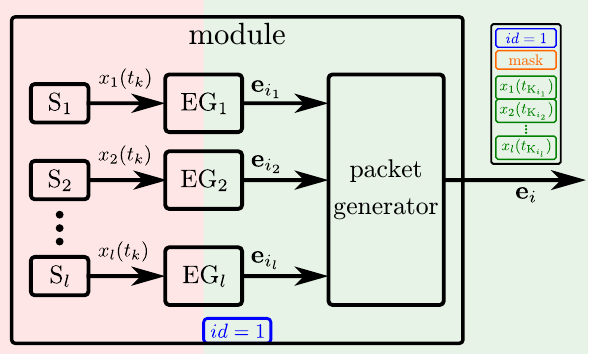
Figure 3. Skin cells/Modules employing several sensors need one event generator EG l per sensor S l ; to reduce the overhead of sending an event packet for each sensor of a skin cell, the skin cell can stack = · · · = t events e i occurring at the same time t K K il into one skin cell event packet e i ; the skin cell i 1 l event packet contains the skin cell ID to identify the module, a mask to identify the sensor, and the ) of the events e sensor values x l ( t K i l il